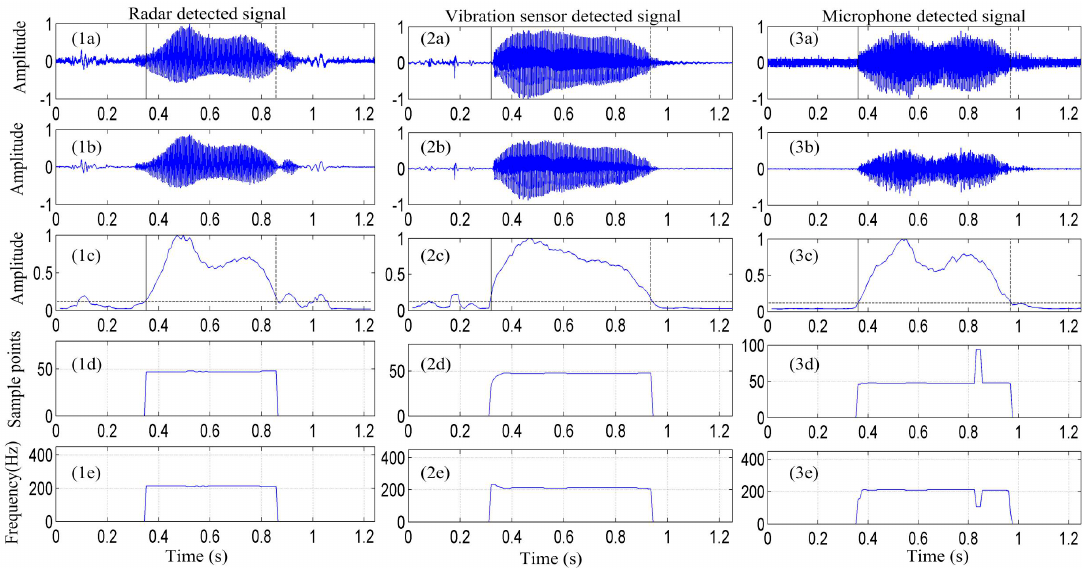
Figure 6. Pitch contours of the signals detected by the radar system, vibration sensor, and microphone system for the vowel sound /a/ obtained using the EMD-ACF algorithm. ( a ) Original detected signal; ( b ) enhanced speech obtained using the EMD method; ( c ) voice activity detection using the ratio of the energy and entropy spectra; ( d ) pitch period of the detected signal; and ( e ) vocal-fold vibration frequency of the detected signal.